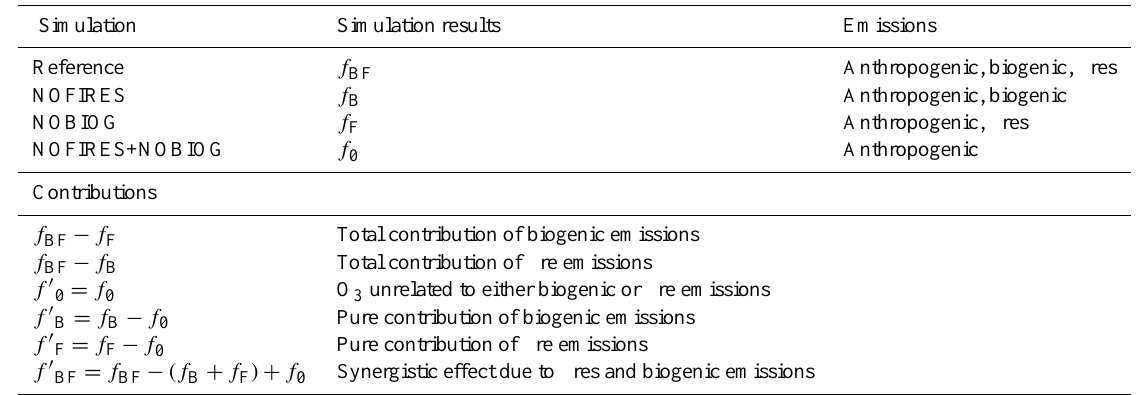
Table 1. Summary of different model runs performed for the application of the FS technique and definitions of the various contribution